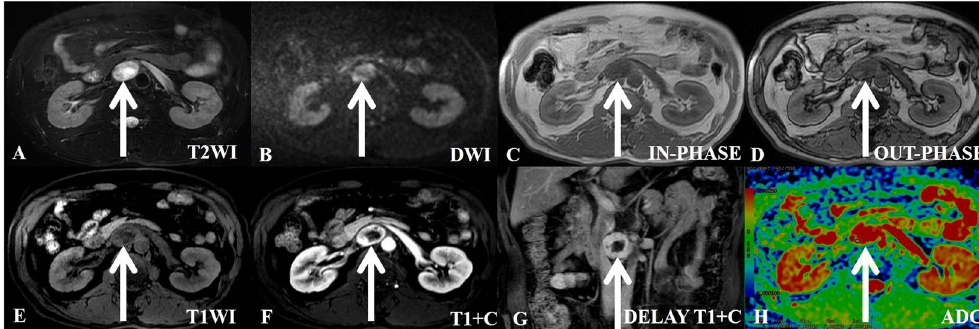
Figure 2. A 47-year-old man with incidentaloma and a histologically proven benign retroperitoneal paraganglioma at the right prevertebral region (among the inferior vena cava, pars horizontalis duodeni and aorta). The transverse and longitudinal diameters of the tumor are 3.92 cm and 3.72 cm, respectively. ( A ) In axial T2-weighted imaging, the tumor demonstrates high signal intensity and isointensity compared with the gluteal muscles. ( B ) In axial DWI, the tumor appears with nodular high signal intensity compared with the spleen. ( C – E ) T1-weighted images (in-phase, out-phase and pre-scanned imaging, respectively); the signal of the tumor is slightly lower than that of the gluteal muscle. ( F ) In contrast T1WI during the arterial phase, the tumor is clearly enhanced and non-homogeneously ring-shaped. The center exhibits no enhancement of the necrotic area. ( G ) In coronal T1WI during the delay phase, the tumor shows a continuous and non-homogeneous signal increase. ( H ) ADC imaging; the mean ADC value of the ROI of the tumor is 0.00180 mm 2